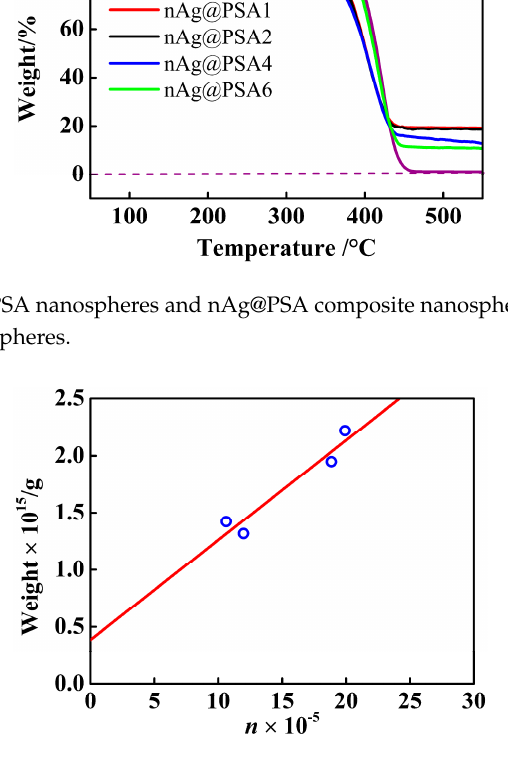
Figure 16. Variation of the Ag nanoparticles weight of composite nanospheres with the number of the carboxyl per particle, n .